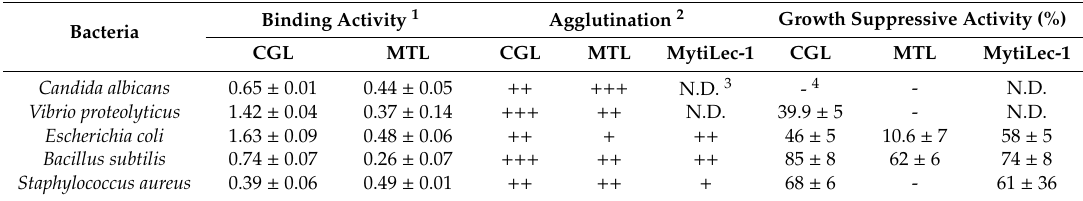
Table 4. Antimicrobial and antifungal activity of CGL [15], MTL [11], and MytiLec-1 [14].